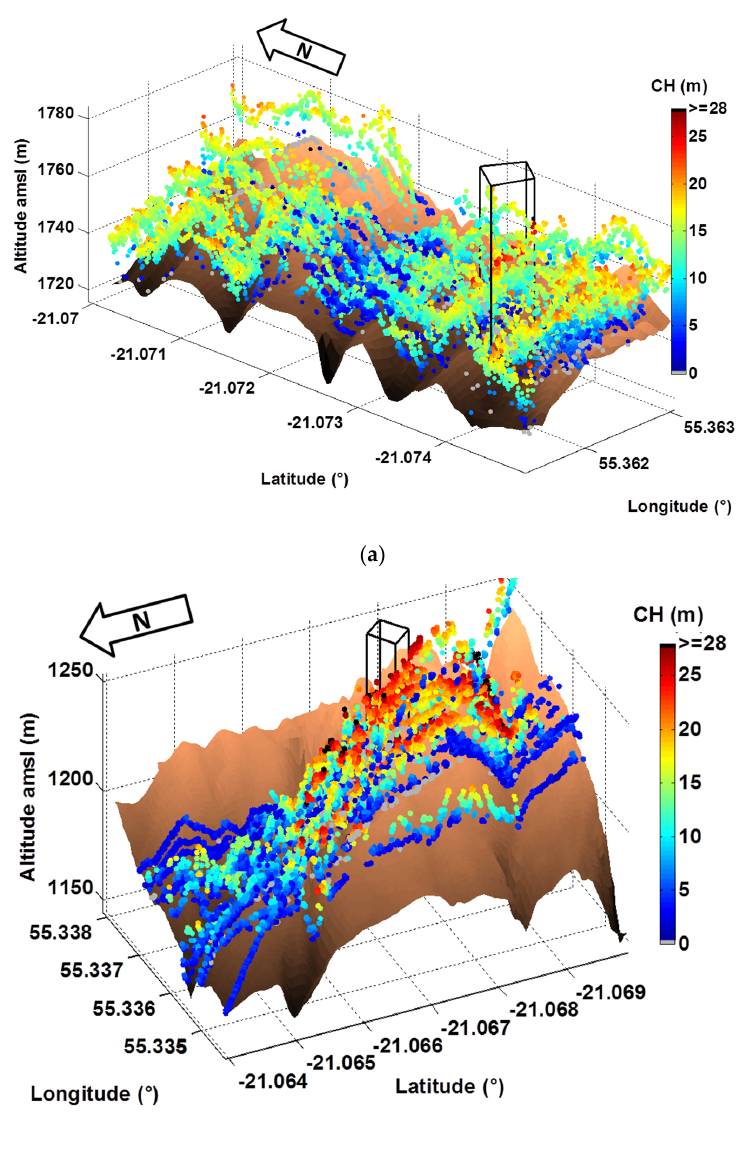
Figure 6. Horizontal samplings performed on the ( a ) Tamarind (TM) and ( b ) Cryptomeria (CM) sites with a laser footprint of 10 m. The horizontal sampling distances along and perpendicular to the ground track are ~1 and ~10 m, respectively. The brown color corresponds to the ground numerical model at a 5-m resolution provided by the Parc National de la Réunion (J.-C. Notter, personal communication). The locations of the sub-plots where in situ measurements were performed are highlighted using thick black lines.